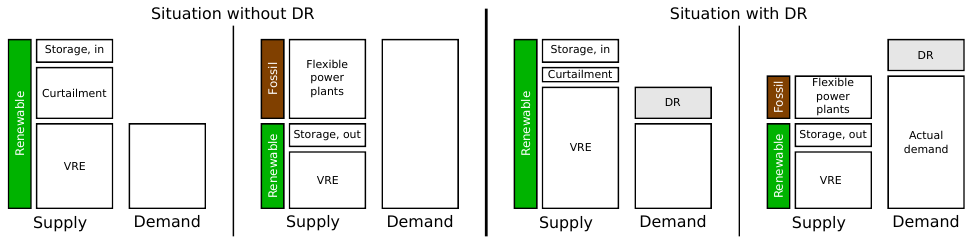
Figure 1. The equilibrium of supply and demand in future energy